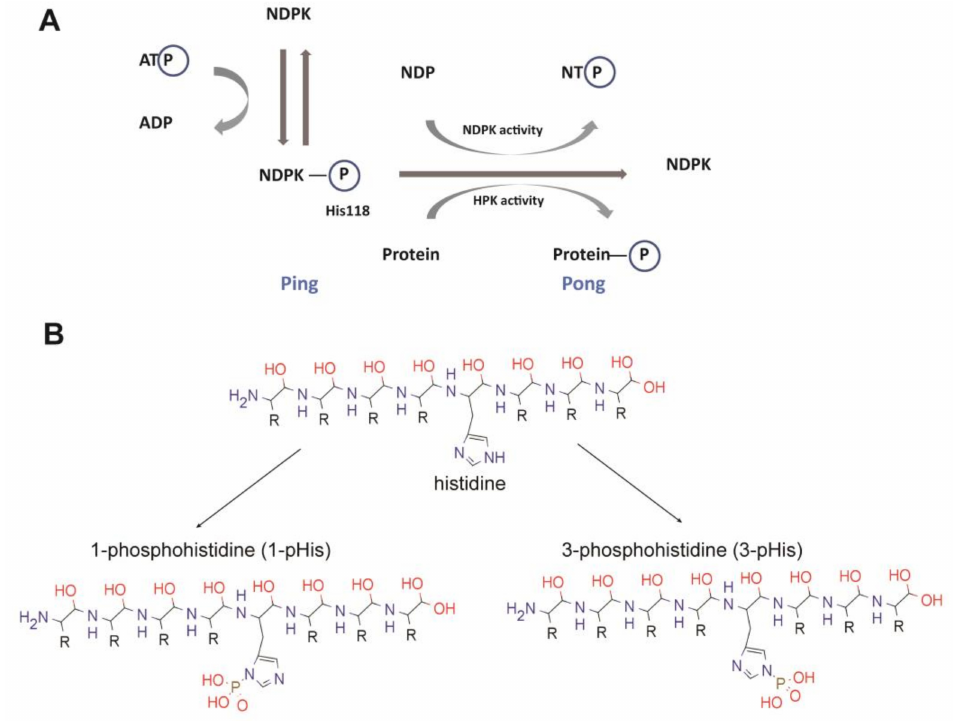
Figure 2. Catalytic mechanism of NDPKs. ( A ) The process of phosphotransfer through NDPK catalysis. The transferred phosphate group is highlighted by blue circles. ( B ) The intermediate states of phosphotransfer through pHis (1-pHis or